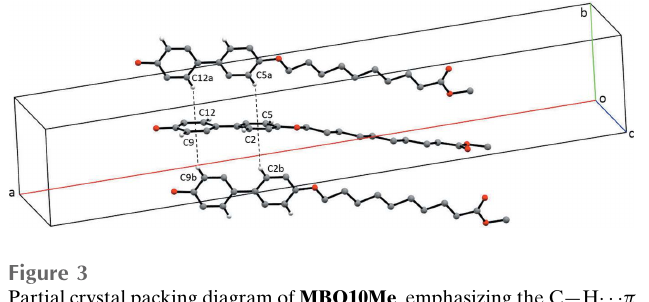
Figure 3 Partial crystal packing diagram of MBO10Me , emphasizing the C—H (cid:2)(cid:2)(cid:2) (cid:2) interactions. Only H atoms involved in these interactions are shown.